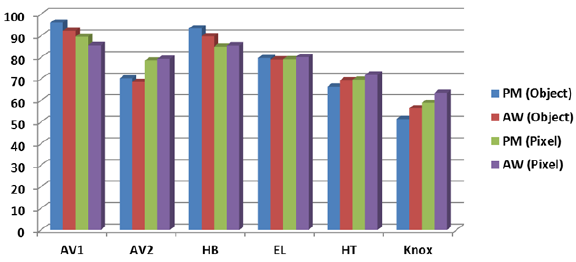
Figure 11: Object and area-based completeness comparison for roof plane extraction process.